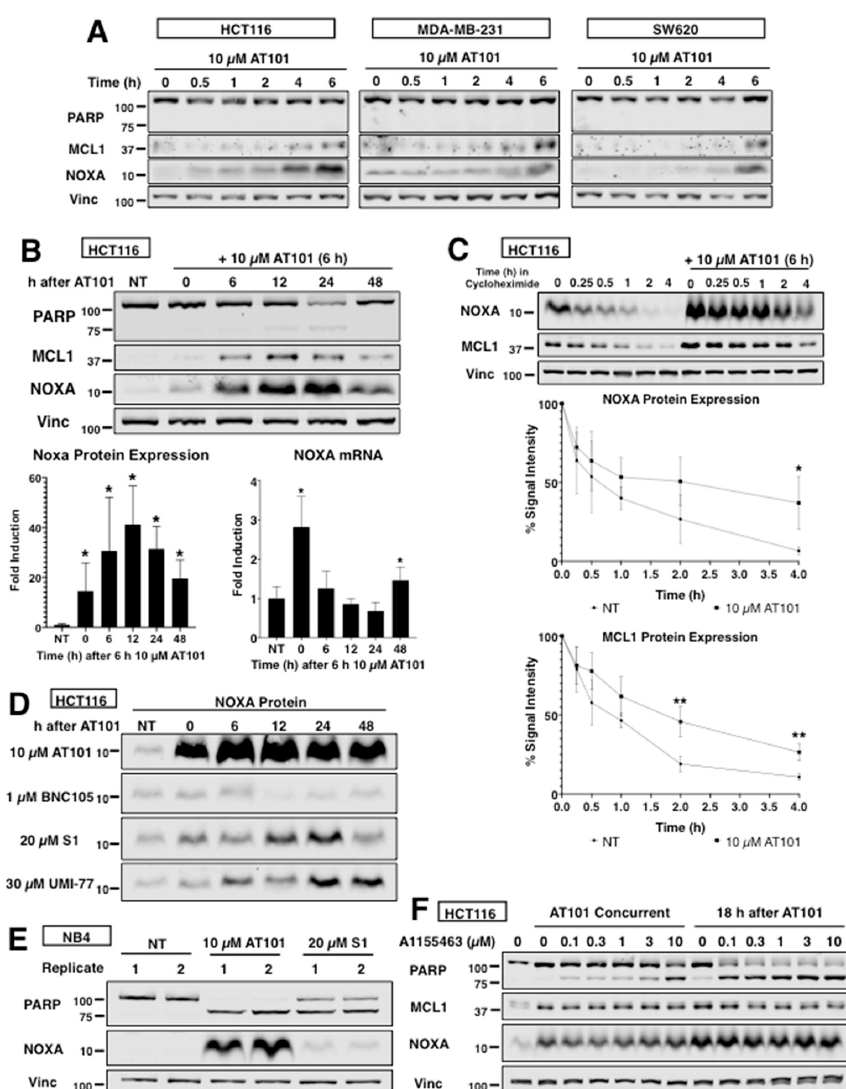
Figure 5. Kinetics of NOXA induction by AT101. ( A ) The indicated cell lines were incubated with 10 μ M AT101 for 0–6 h and analyzed for NOXA and MCL1 protein expression. ( B ) HCT116 cells were incubated with 10 μ M AT101 for 6 h, then washed and incubated for a further 6–48 h. Protein expression was calculated based on signal intensity normalized to vinculin and error bars represent the range of fold-change values ( n = 3, * p < 0.05). NOXA mRNA was quantified by qPCR and error bars represent the range of fold-change values and statistical analysis was applied to the dC(t) values ( n = 3, * p < 0.05). ( C ) HCT116 cells were incubated with 50 μ g/mL cycloheximide for 0–4 h. Alternatively, cells were incubated with 10 μ M AT101 for 6 h, then released into media for 18 h, then 50 μ g/mL cycloheximide was added for an additional 0–4 h. NOXA and MCL1 protein expressions were calculated using signal intensities normalized to the 0 h lysate. Error bars represent standard deviation ( n = 3, * p < 0.05, ** p < 0.01). ( D ) HCT116 cells were incubated with either 10 μ M AT101, 1 μ M BNC105, 20 μ M S1 or 30 μ M UMI-77 for 6 h, then washed and incubated for a further 6–48 h. ( E ) NB4 cells were incubated with either 10 μ M AT101 or 20 μ M S1 for 6 h, then washed and incubated for a further 24 h. ( F ) HCT116 cells were incubated with 10 μ M AT101 for 6 h concurrently with A1155463, or with AT101 for 6 h followed at 18 h by a 6 h incubation with A1155463. Cell lysates were analyzed for PARP cleavage, NOXA and MCL1 protein expression.